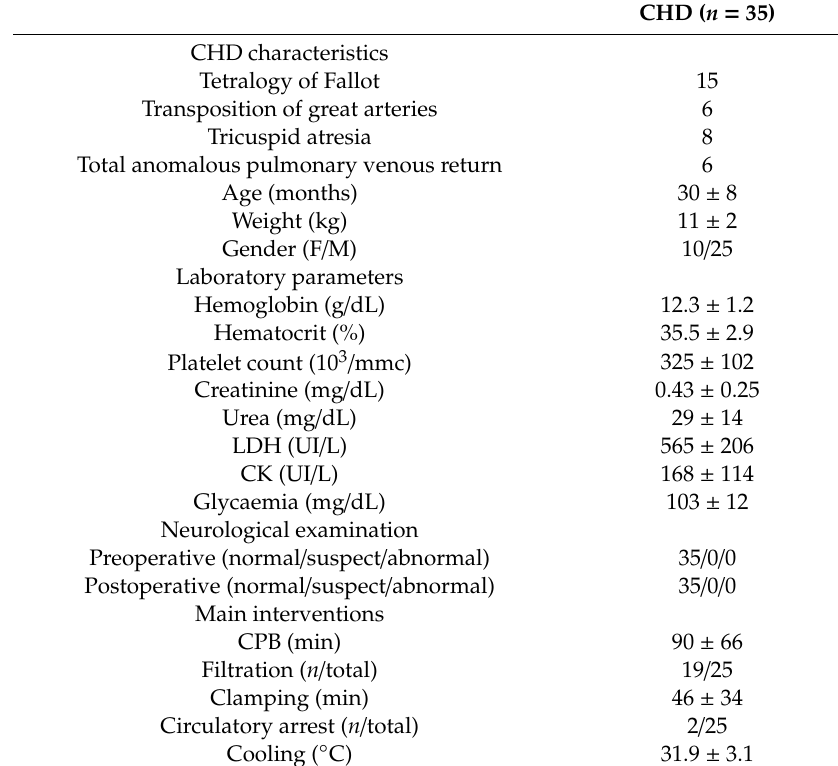
Table 1. Laboratory parameters, main interventions, and general characteristics of the children with complications of congenital heart disease (CHD) admitted into the